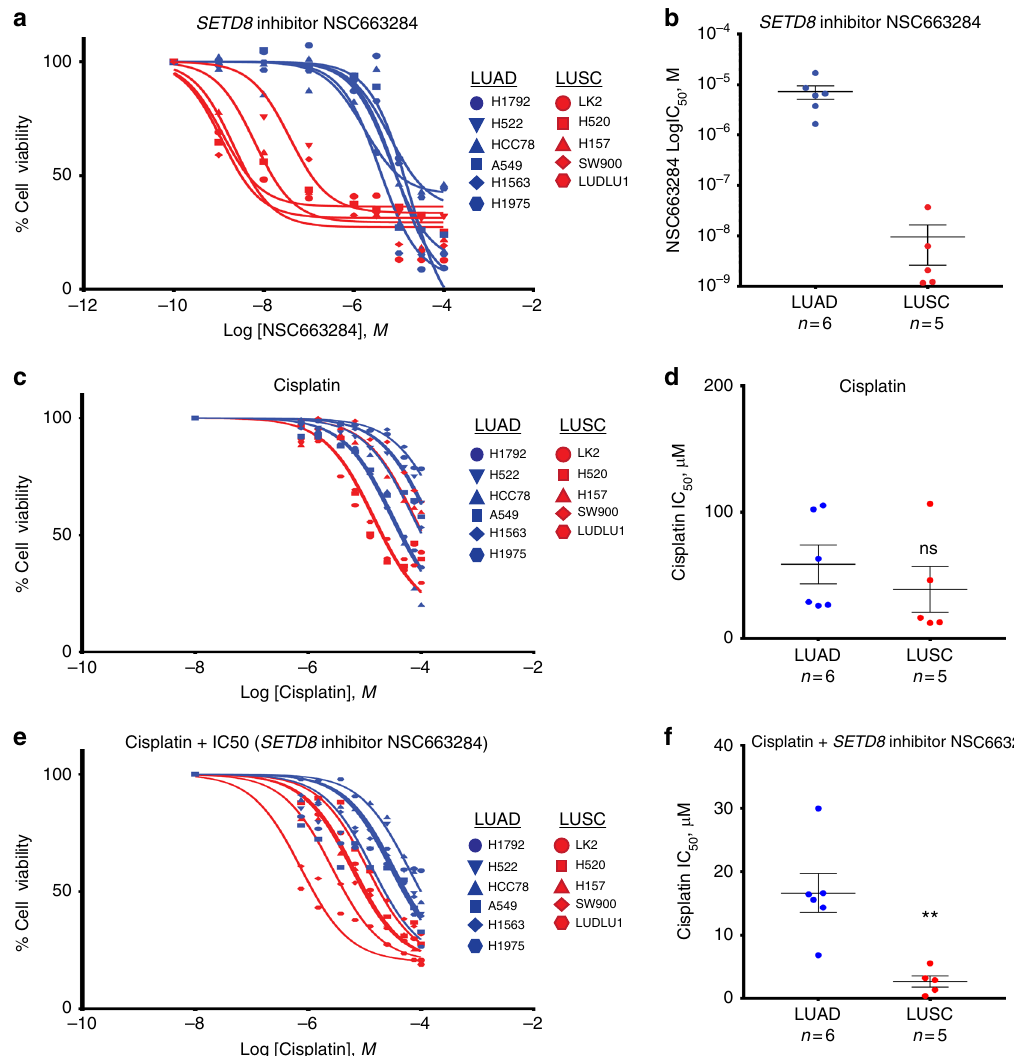
Fig. 6 SETD8 inhibition preferentially sensitises LUSC cell lines to chemotherapy. a Dose – response curves were derived by treating NSCLC cell lines with SETD8 inhibitor NSC663284. 1000 cells were seeded and allowed to recover for 24 h. The inhibitor was then added at increasing concentrations to LUSC (red) and LUAD (blue) cells and Cell Titre (see Methods) assay was performed after 72 h. b IC 50 values were derived from the dose – response assay indicating LUSC cells are signi fi cantly more responsive to SETD8 inhibition than LUAD cells. c Dose – response curves were derived by treating NSCLC cell lines with cisplatin as above. d IC 50 values were derived from the dose – response assay indicating cisplatin effects LUSC and LUAD cells equally. e Dose – response curves derived from treating NSCLC cell lines with cisplatin and NSC663284 IC 50 concentration for each cell line as above. f IC 50 values were derived from the dose – response assay indicating SETD8 inhibition preferentially enhances cisplatin ef fi cacy in LUSC cells. The whiskers indicate the range of the data and the line represents the median. Data presented as mean ± s.d. (LUSC n = 5 and LUAD n = 6). Student ’ s t -test performed, * p < 0.05, ** p < 0.005 and *** p <